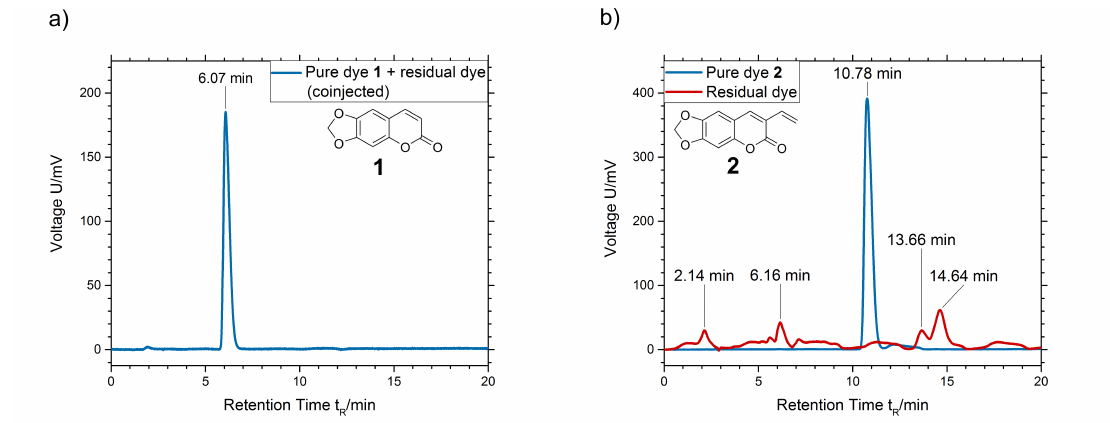
Figure 5. High-performance liquid chromatography (HPLC) chromatogram of ( a ) ayapin 1 and ( b ) pure dyes and residuals from precipitation for 3-vinylayapin 2 . As reference, both dyes 1 and 2 were used in concentrations of 0.001mol · L − 1